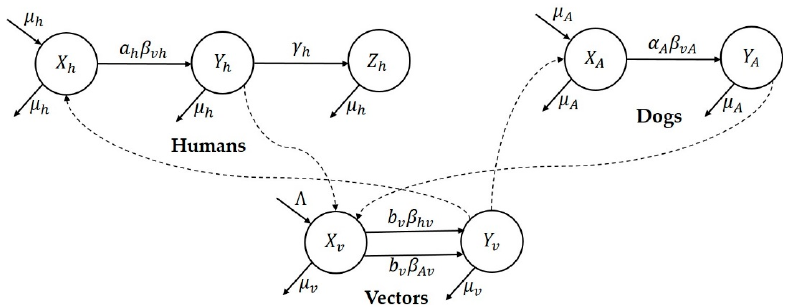
Figure 4. Flow chart representing the mathematical model for Madrid. Table 2. Variables and parameters of model used for Madrid.